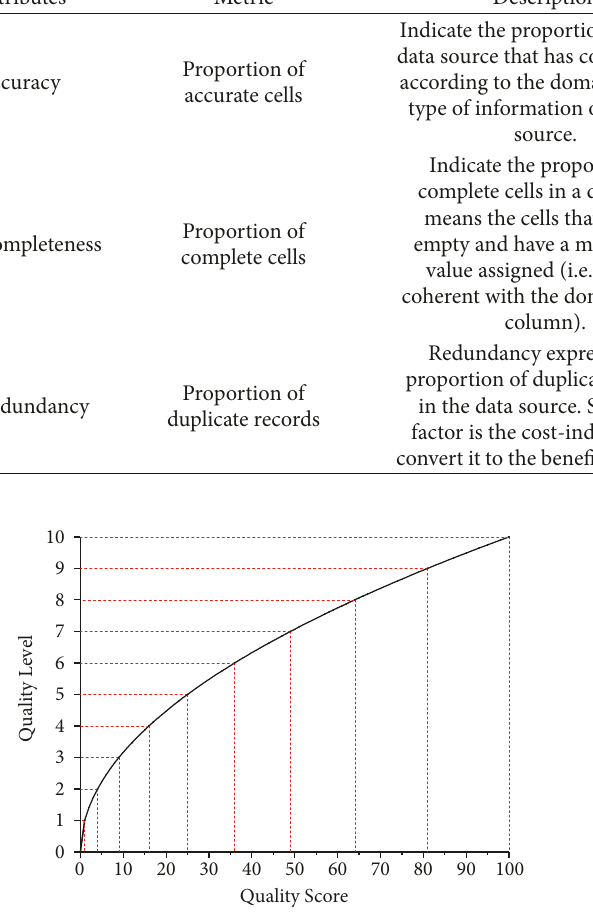
Figure 2: Mapping of quality scores and levels.